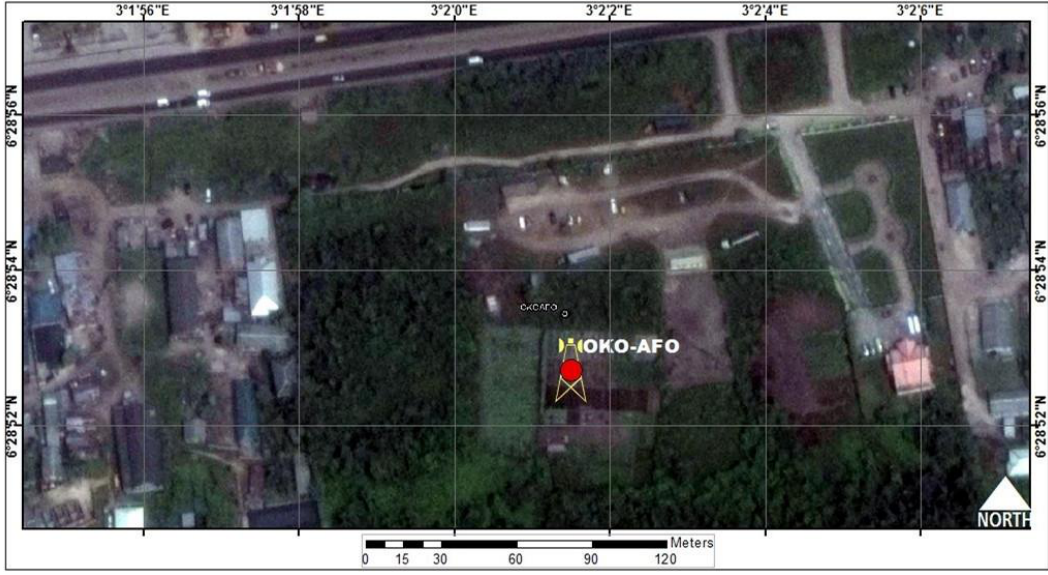
Figure A1. Okoafo. Figure A1.